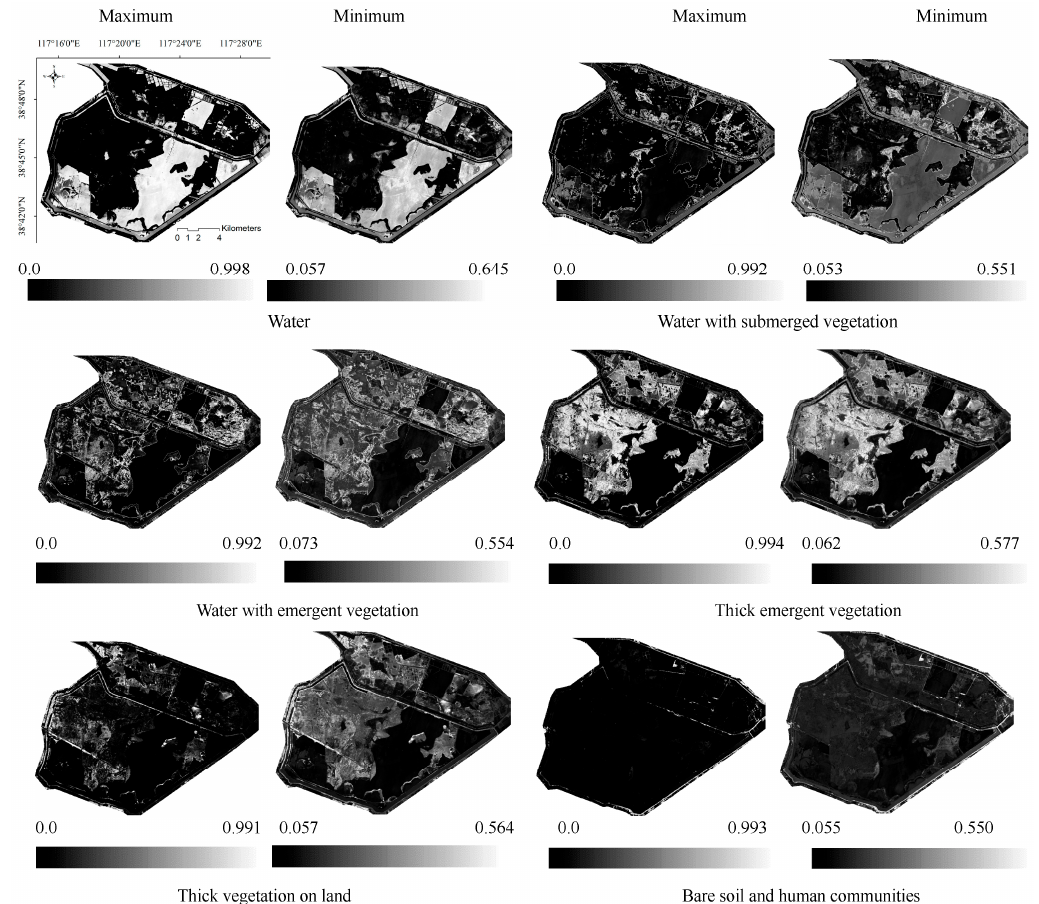
Figure 6. Maps of the type 2 fuzzy land cover types of the study area based on long-term series of Landsat satellite data starting from 4 September 2005. The land cover types in each year are divided into two columns: one is the cover type with the maximum membership, and the other is the cover type with the minimum membership.